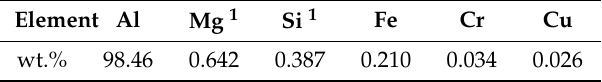
Table 2. Chemical composition of